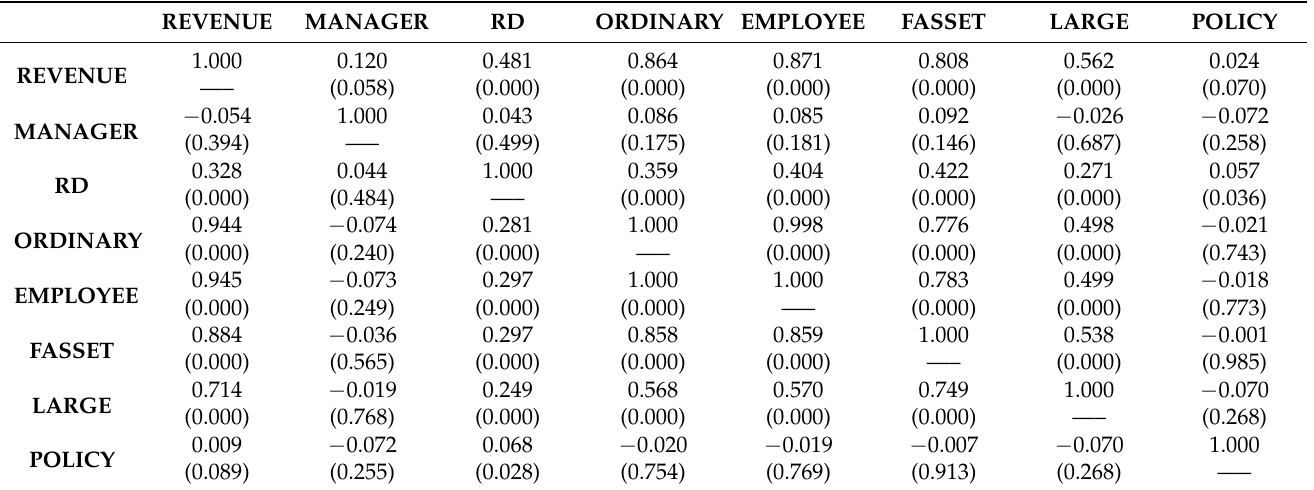
Table 4. Correlation matrix for dependent and independent variables ( p -values in